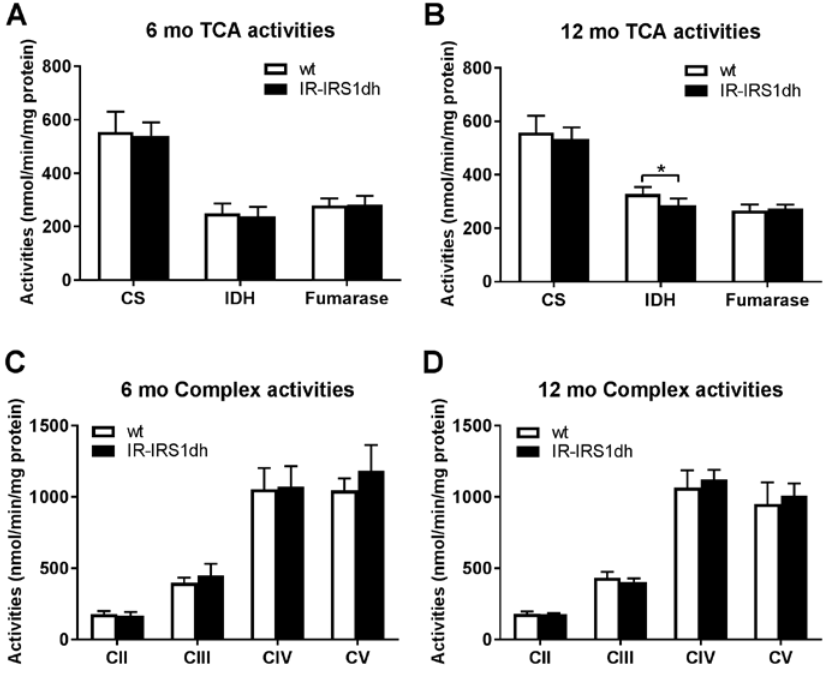
Figure 2. Skeletal muscle mitochondrial activities of IR-IRS1dh mice. ( A , B ) Mitochondrial tricarboxylic cycle (TCA) and ( C , D ) respiratory complex activities determined in skeletal muscle homogenates. CS: citrate synthase; IDH: isocitrate dehydrogenase; C denotes mitochondrial complexes II–V. Columns represent mean values ± standard deviations, n : 4–6; * denotes significant differences between IR-IRS1dh mice compared to wt controls; * p < 0.05.